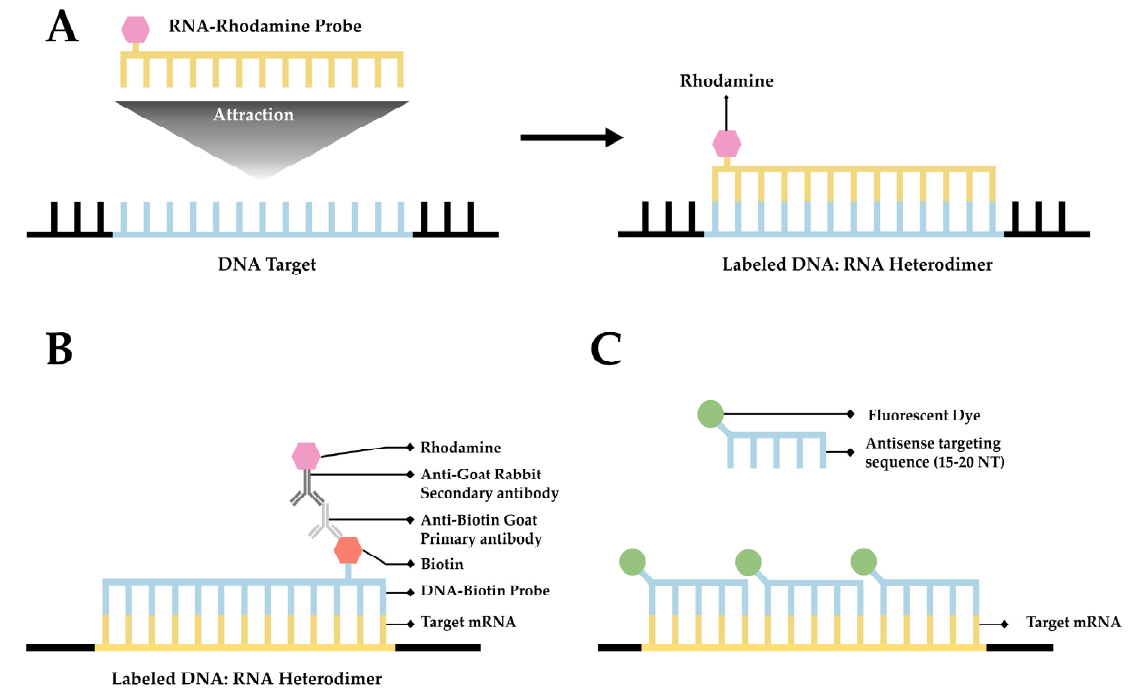
Figure 1. A simplified diagram depicting fluorescent in situ hybridization (FISH). ( A ) The first FISH experiment in DNA performed by Bauman and colleagues [52], in which a target DNA sequence (Blue) forms and RNA:DNA heterodimer with an RNA (Green) probe conjugated with Rhodamine (Red). ( B ) The first mRNA FISH experiment performed by Singer & Ward [54], in which a target mRNA sequence (Green) formed a DNA:RNA heterodimer with a complimentary DNA sequence (Blue) conjugated to biotin (purple). A primary anti-Biotin Goat derived primary antibody (Dark Blue) associates with the biotin tag. A secondary anti-Goat rabbit derived antibody (Light Red) conjugated to a Rhodamine (Dark Red) then associates with the primary antibody forming a complete fluorescent label. ( C ) The core principle of single-molecule FISH (smFISH), in which a target mRNA (Green) is targeted with short sequential antisense oligonucleotides (Blue), each 15–20 nucleotides long, that are each conjugated to a fluorescent dye (Dark Green).